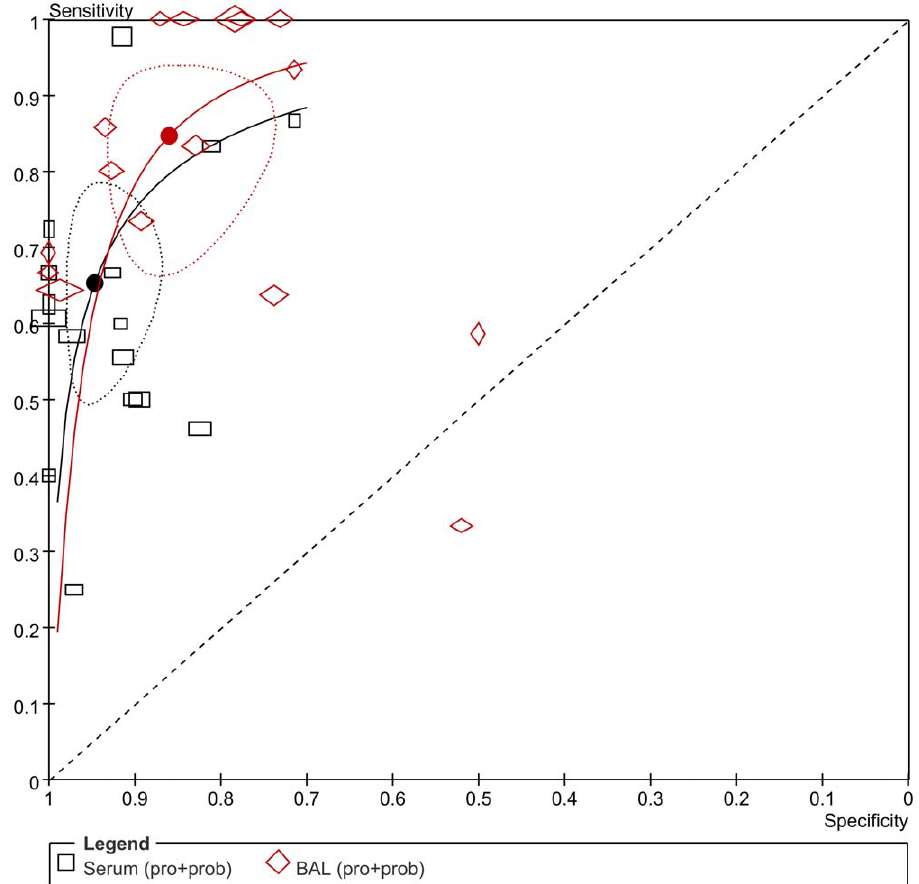
Figure 8. Summary ROC plot of SEN and SPE of serum GM and BAL-GM. (Dotted ellipses around the spots represent the 95% CI around the summary estimates. The diamonds and rectangles represent individual studies and size of the diamonds/rectangles is proportional to the number of patients included in the study).